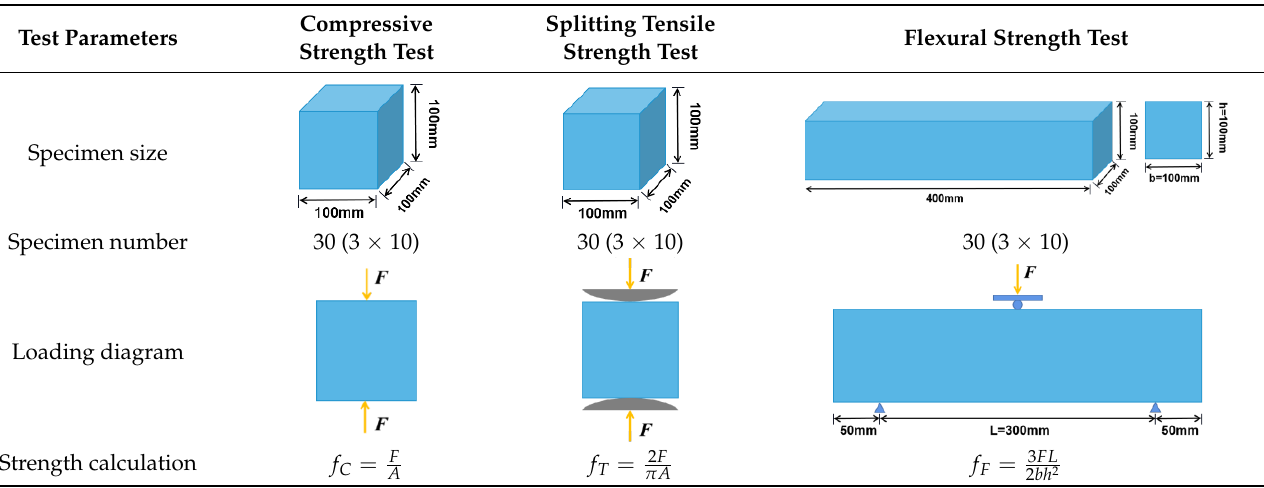
Figure 4. Strength tests. ( a ) compressive strength test; ( b ) splitting tensile strength test; ( c ) flexural strength test. Figure 5. Details of porosity test process. Table 8. The test parameters of strength tests.